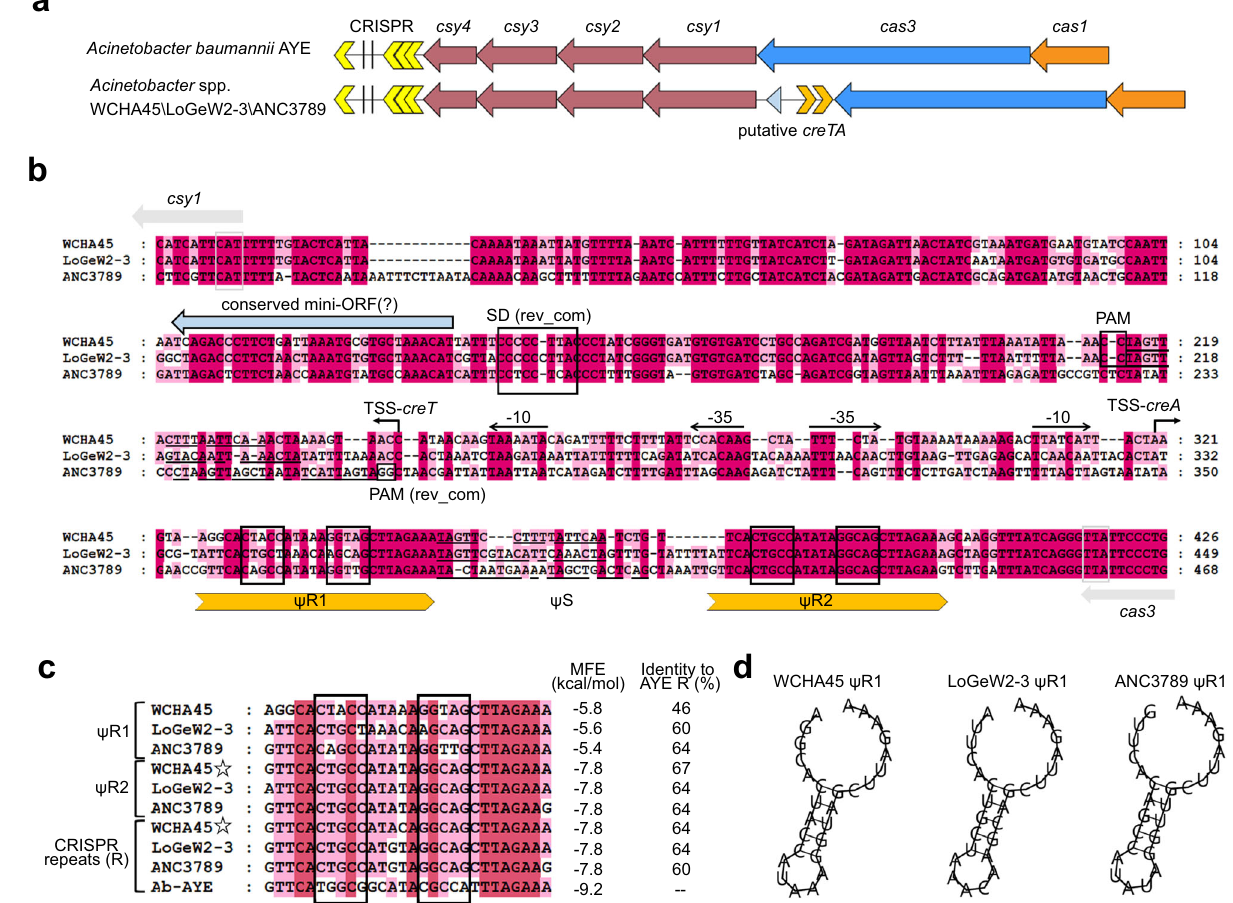
Fig. 1| ThreeputativeCreTA modulesassociating with thetypeI-FCRISPR-Cas from Acinetobacter species. a Scheme depicting the putative creTA module residingwithinthe cas3-csy1 intergenicregion(IGR).TheCRISPR-Caslocusofthe A. baumannii strain AYE which lacks this IGR is given for comparison. b Sequence alignment of the three creTA- containing IGRs. Each creA gene contains a ‘ spacer ’ sequence ( Ψ S) that is sandwiched by two CRISPR repeat-like sequences ( Ψ R1 and Ψ R2).Each Ψ Rispalindromicandcontainsapairofinvertedrepeats(framed).The identical nucleotides shared between each Ψ S and its predicted target are under- lined, and the protospacer adjacent motif (PAM) or its reverse complement